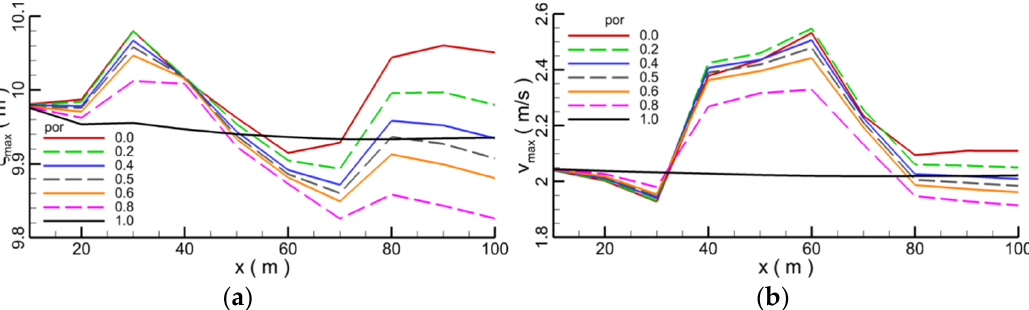
Figure 9. The maximum water level and velocity recorded under different porosities; ( a ) water level; ( b ) velocity.